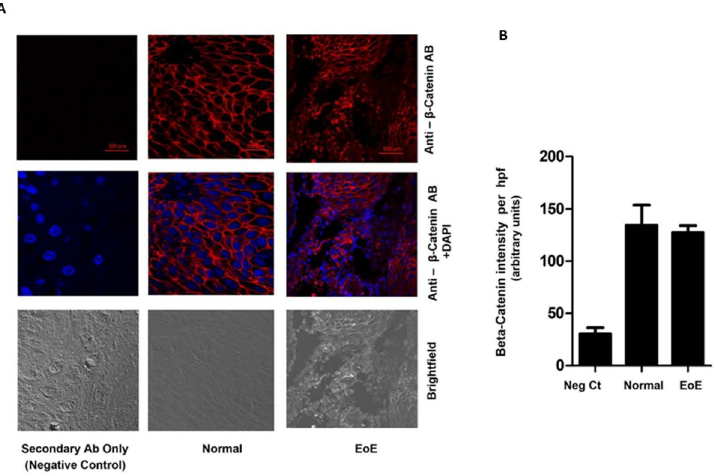
Fig 4. IF and IHC analysis of β -catenin in esophageal tissue from pediatric control (0–5 Eos/HPF) and EoE patients ( > 15 Eos/HPF). A. Representative photomicrograph of immunostaining (IF) with anti- β -catenin antibody. B. Densitometric analysis of β -catenin staining in EoE and control patient esophageal biopsy tissue.